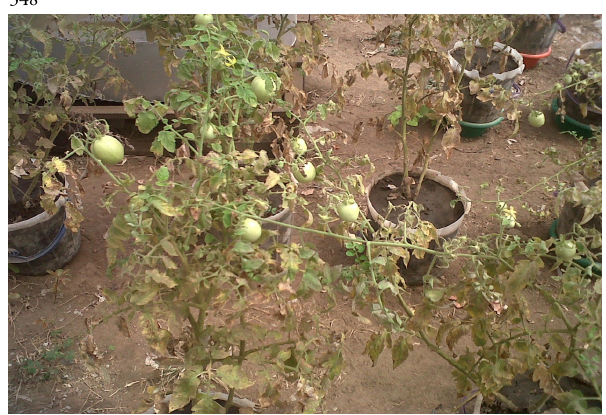
Fig. 3. Tomato plant irrigated with magnetic treated water after 120 days with more fresh leaves and tomato fruits